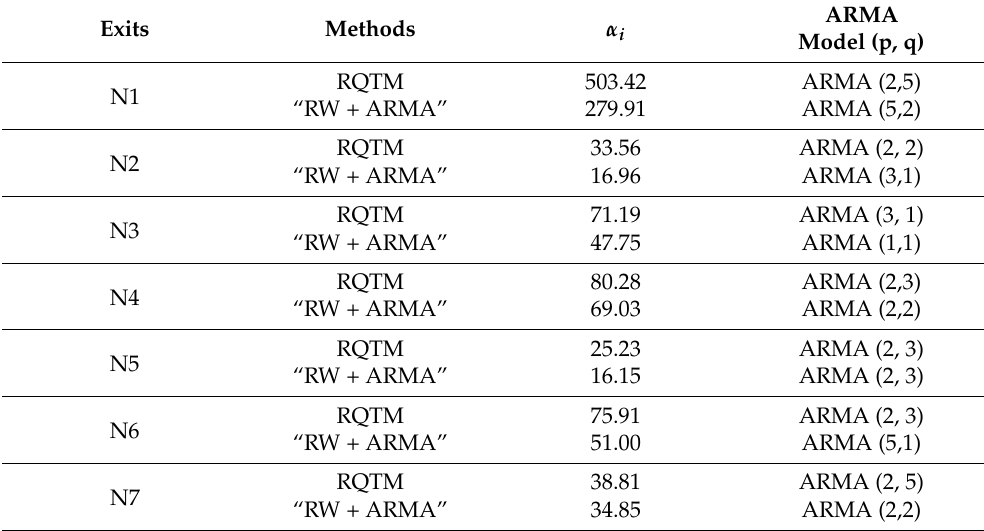
Table 3. The coefficients of RQTM.